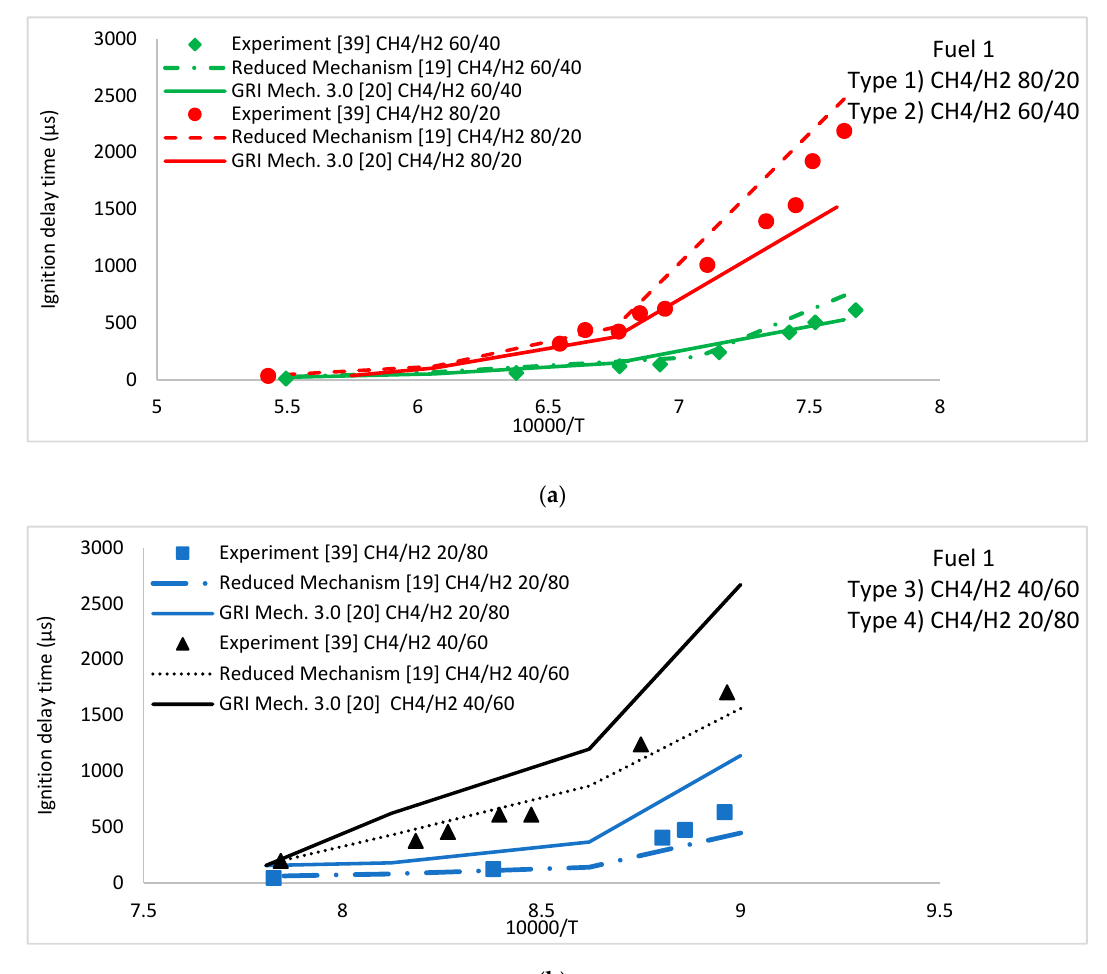
Figure 1. Comparison of the calculated ignition delay time by using the reduced mechanism [19] and GRI Mech. 3.0 [20] and the experimental measurements from Reference [39] for ( a ) Fuel 1 Type 1 and Type 2; and ( b ) Fuel 1 Type 3 and Type 4 at pressure 5 bar and equivalence ratio 0.5.